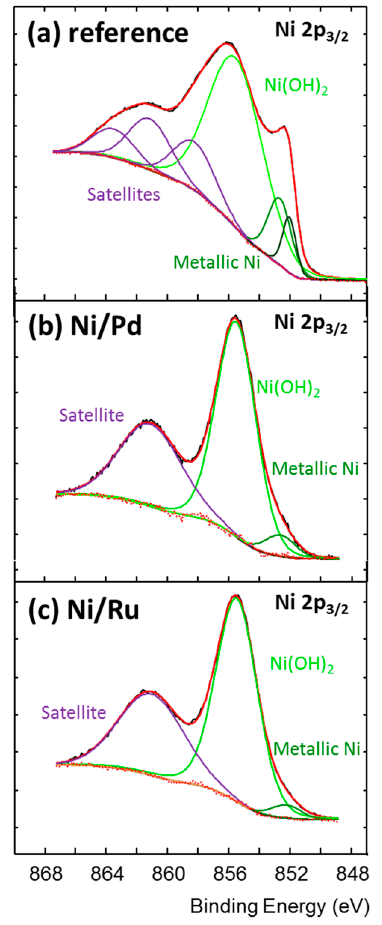
Figure 3. The high-resolution XPS spectra of Ni2p3/2 for ( a ) the reference sample, ( b ) the Ni/Pd system, and ( c ) the Ni/Ru system. A black line represents the measured data, the red line represents the fitted data, and the dotted red line represents the difference between the measured and fitted data. Individual contributions to the fitted data are represented by the colored lines and were assigned to a specific chemical state.